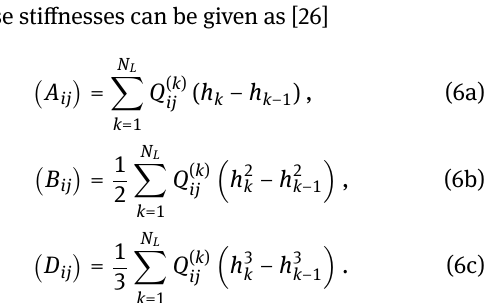
Figure 1: Functionally graded circular